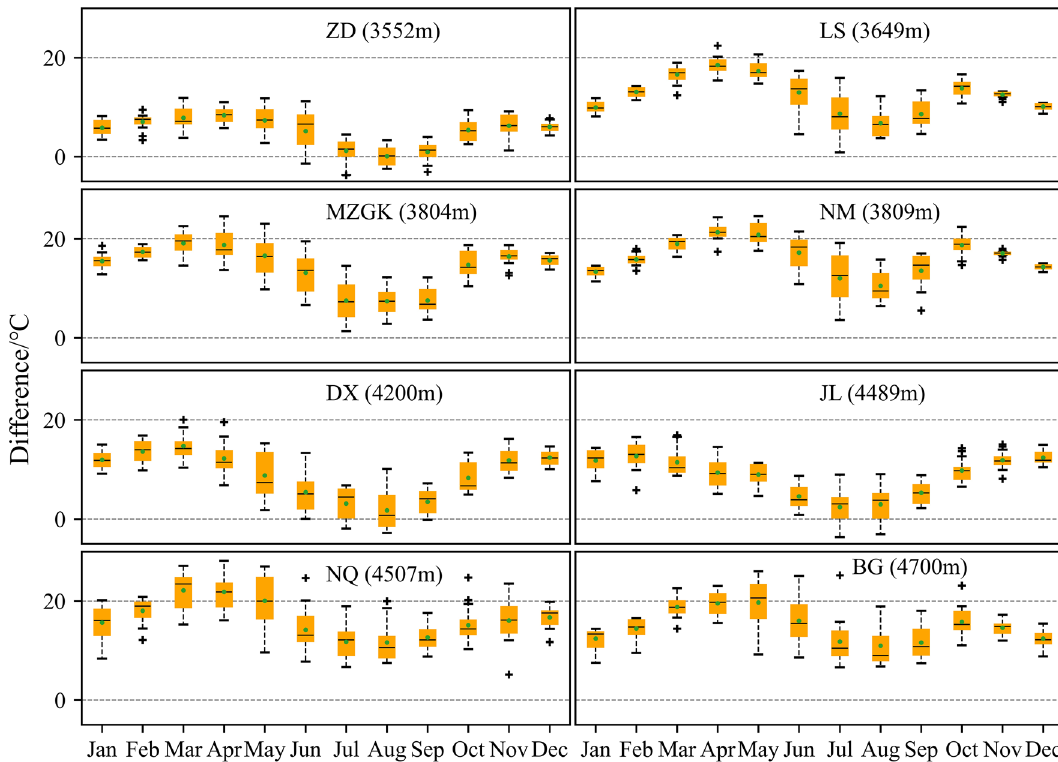
Figure 3. Boxplots of the D-value between LSTemp and air temperature. All eight diagrams had the same X- and y-axis scales and each boxplot were marked with 15 different values of 2001–2015.